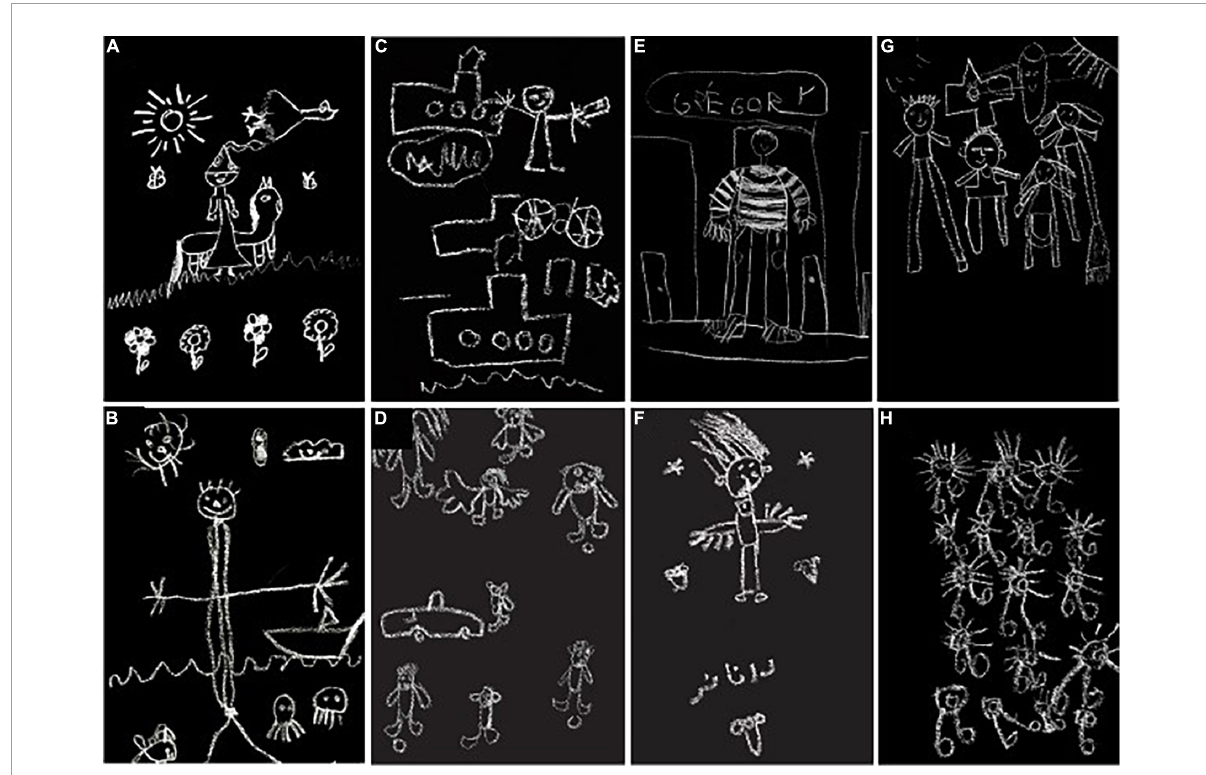
FIGURE3 Examples of drawings. Four types of non-human figures have been considered: elements representing nature (e.g., tree, flowers, sun; A,B ), man-made objects (e.g., house, car, and boat, B–E,G ), symbols (F) , and characters (i.e., letters or numbers, E ).